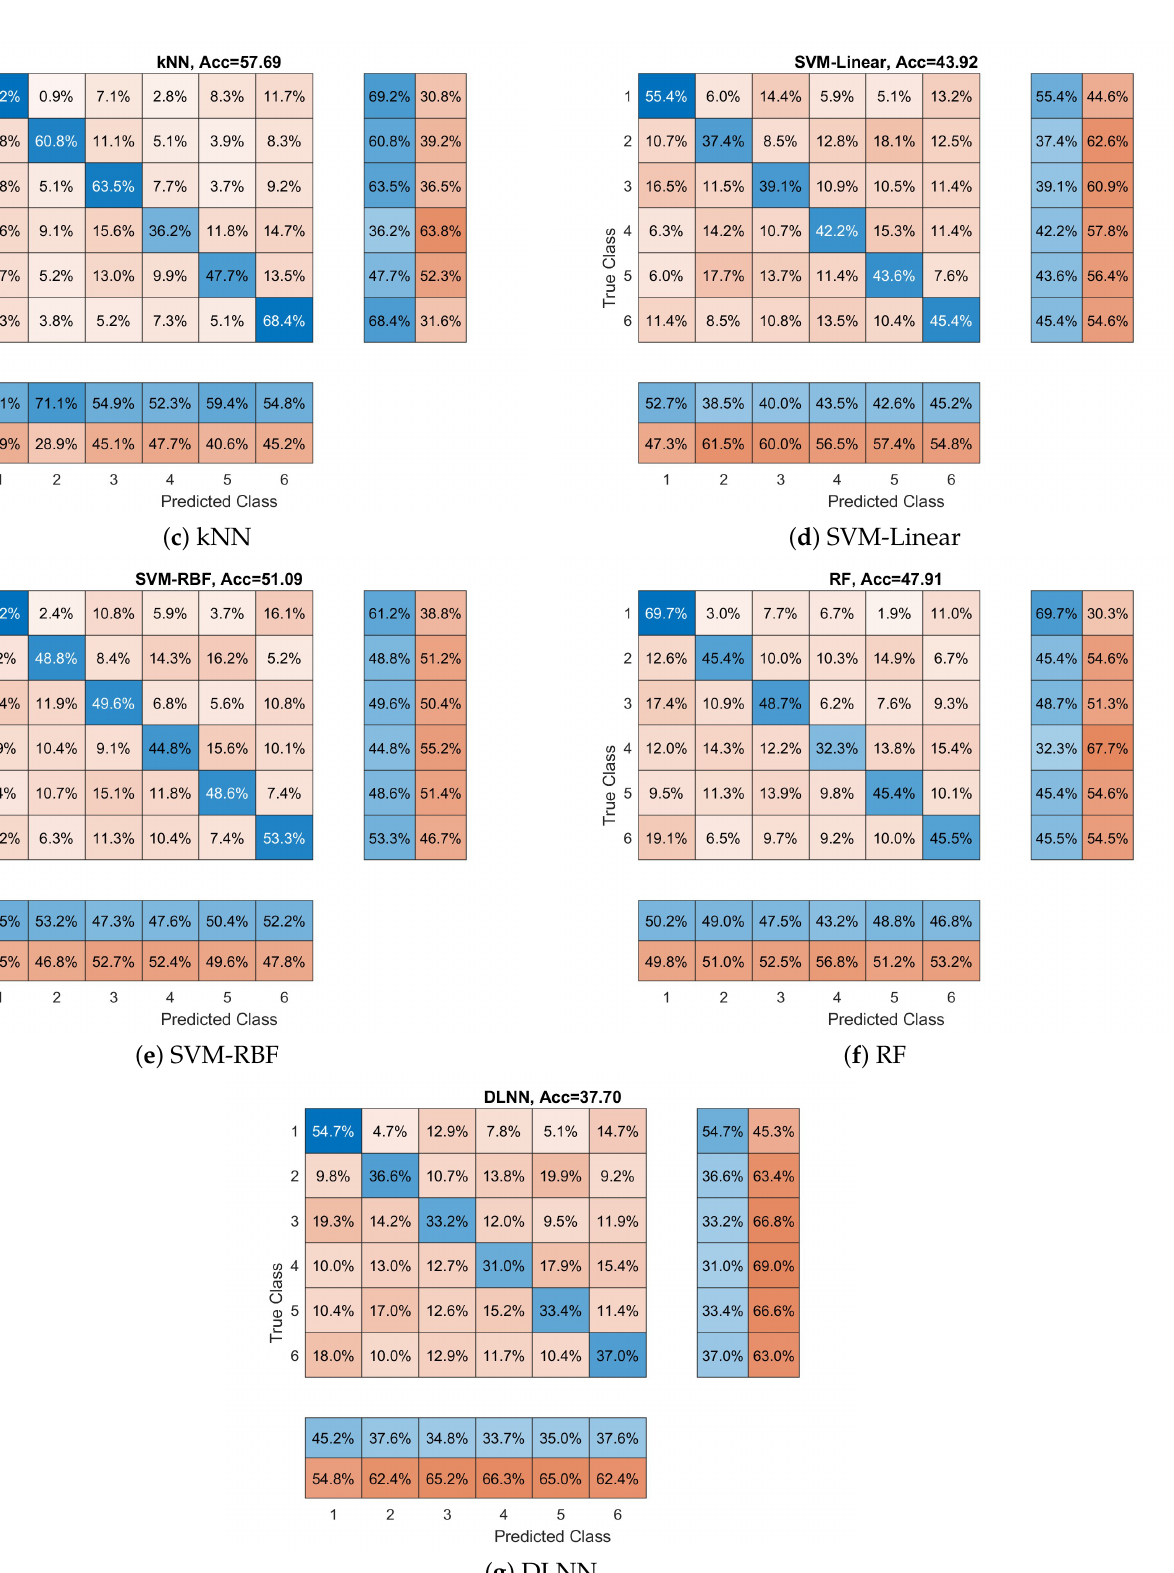
Figure 3. Overall accuracy and confusion matrices for each method with respect to which product the participant views. These matrices provide the performance of each classifier with respect to each class (in our case participant views). Furthermore, the class-wise precision (last two separated columns on the right) and class-wise recall (last two separated rows on the bottom) are